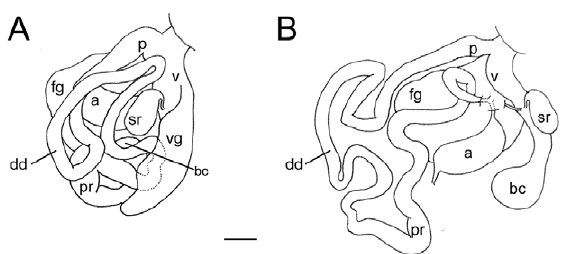
Fig. 4. – Complete reproductive system of Felimare aurantimacu- lata n. sp. (MB28-004391). A, original view. B, view with all the organs separated. Abbreviations: a, ampulla; bc, bursa copulatrix; dd, deferent duct; fg, female gland; p, penis; pr, prostate; sr, seminal receptacle; v, vagina; vg, vestibular gland. Scale bar=0.5